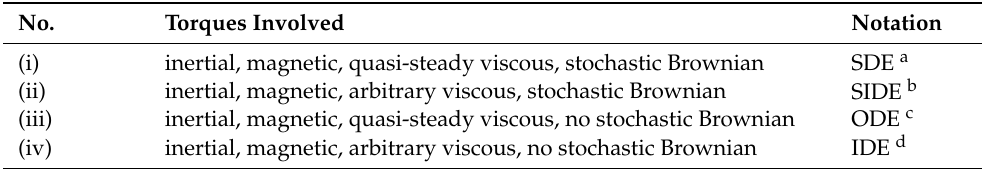
Table 2. Model notation with specified torques involved in